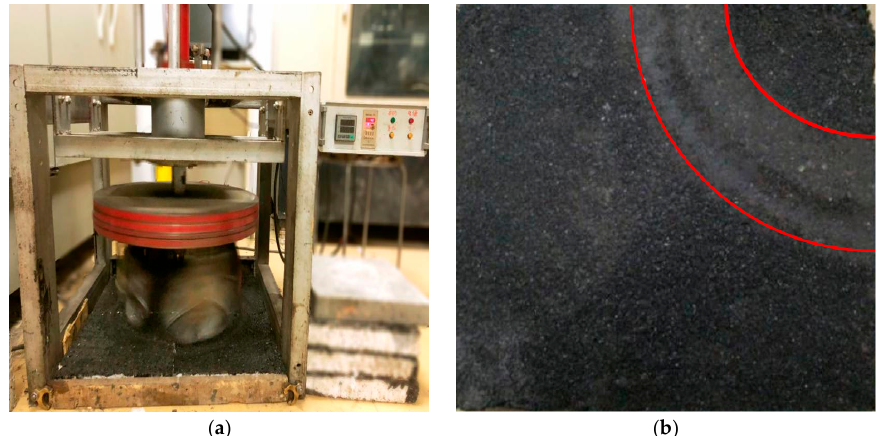
Figure 8. Wear resistance test: ( a ) accelerated wear tester; ( b ) tire trajectory after wear.